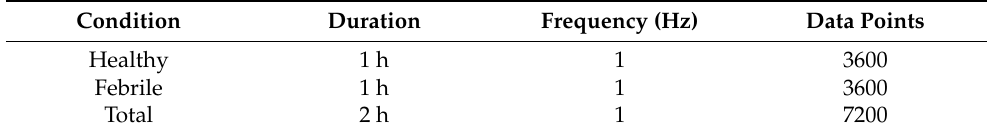
Table 2. Number of data points available.